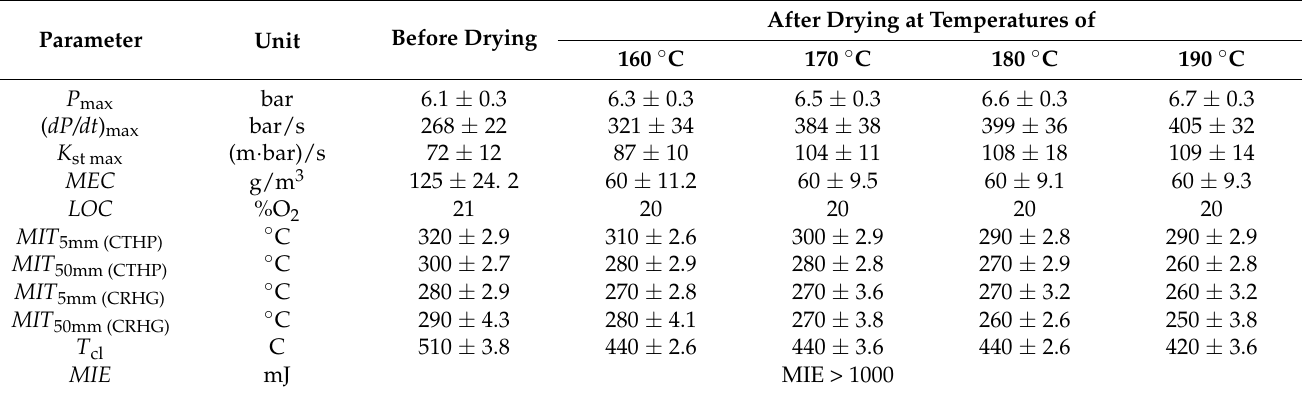
Table 4. Results of explosion and fire properties of